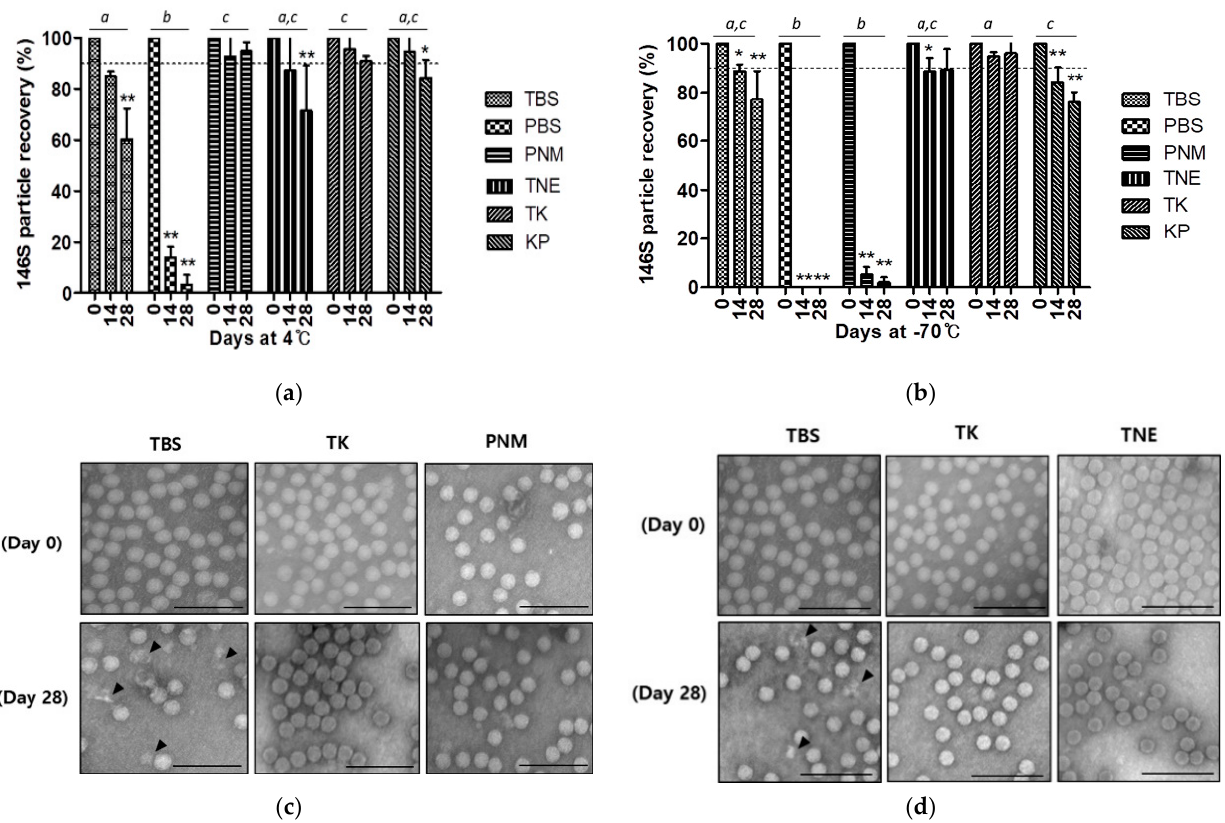
Figure 2. Effectivity of buffers for short-term storage of FMDV O JC vaccine antigen. ( a ) The 146S particle recovery (%) in each buffer during 4-week storage at 4 °C; ( b ) The 146S particle recovery (%) in each buffer during 4-week storage at − 70 °C. The dotted line is set at 90% recovery. *, p < 0.05, **, p < 0.01. Different lowercase letters indicate significant differences at p < 0.05; ( c ) Microscopic observation of 146S particles stored in the aqueous phase; ( d ) Microscopic observation of 146S particles stored in frozen phase. Scale bar = 100 µm. Arrowheads indicate degrading particles. Abbreviations: TBS, Tris-buffered saline (pH 7.6); PBS, phosphate-buffered saline (pH 7.6); PNM, PBS supplemented with NaCl and MgCl2 (pH 7.6); TNE, TBS supplemented with ethylenediaminetetraacetic acid (pH 7.6); TK, Tris-KCl buffer (pH 7.6); KP, potassium phosphate buffer (pH 7.6).